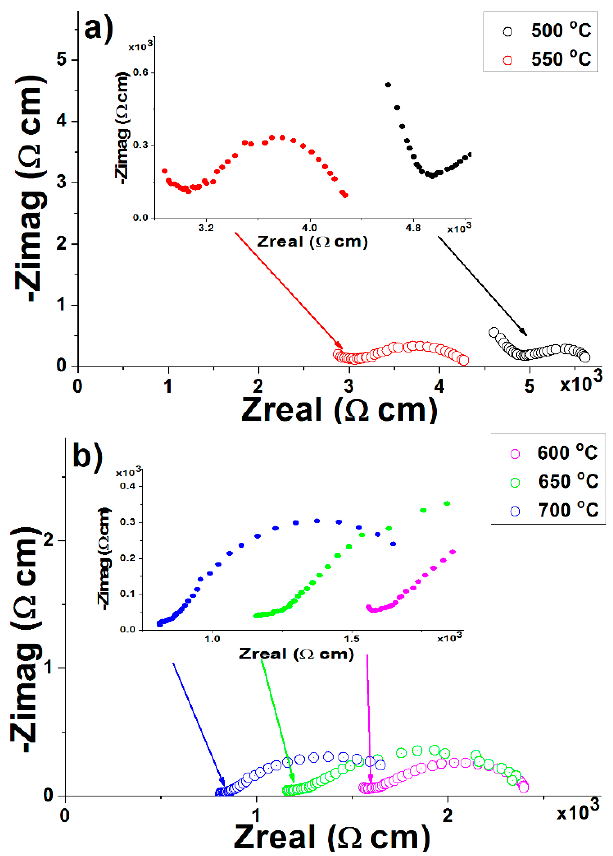
Figure 11. Complex impedance plots of GP_CeO 2 _MGNP sample measured in different temperature ranges: ( a ) from 500 to 550 °C; ( b ) from 600 to 700 °C, in an air atmosphere. The arrows indicate the points on the real axis corresponding to the readings R b + R gb .